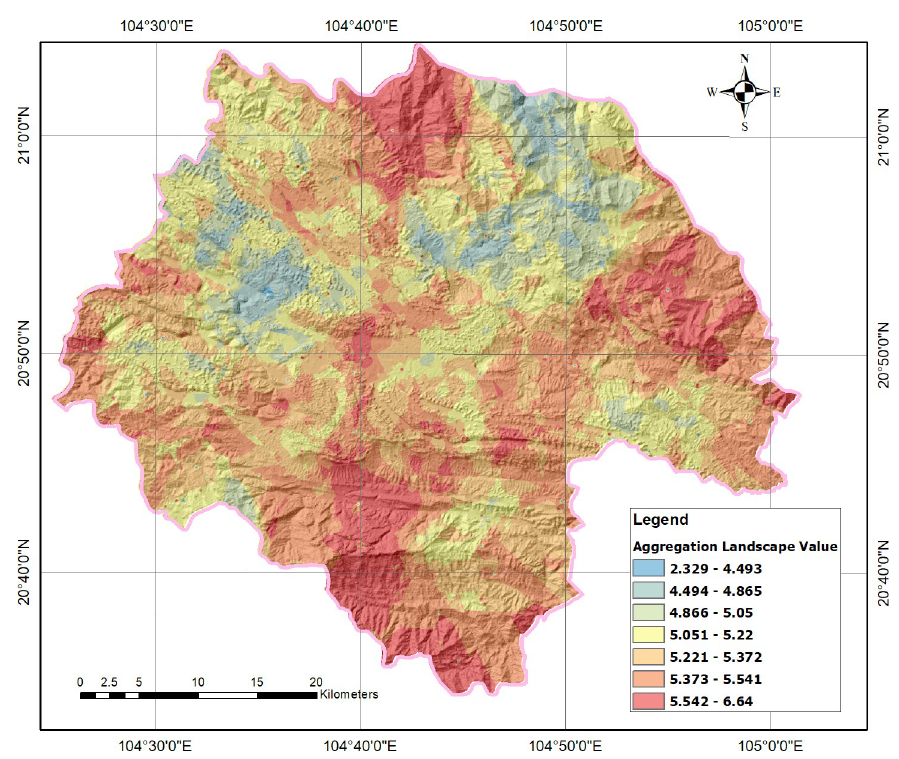
Fig 5. Aggregation landscape value map of Moc Chau District (using ordinary kriging method of interpolation with the spherical semivariogram model).